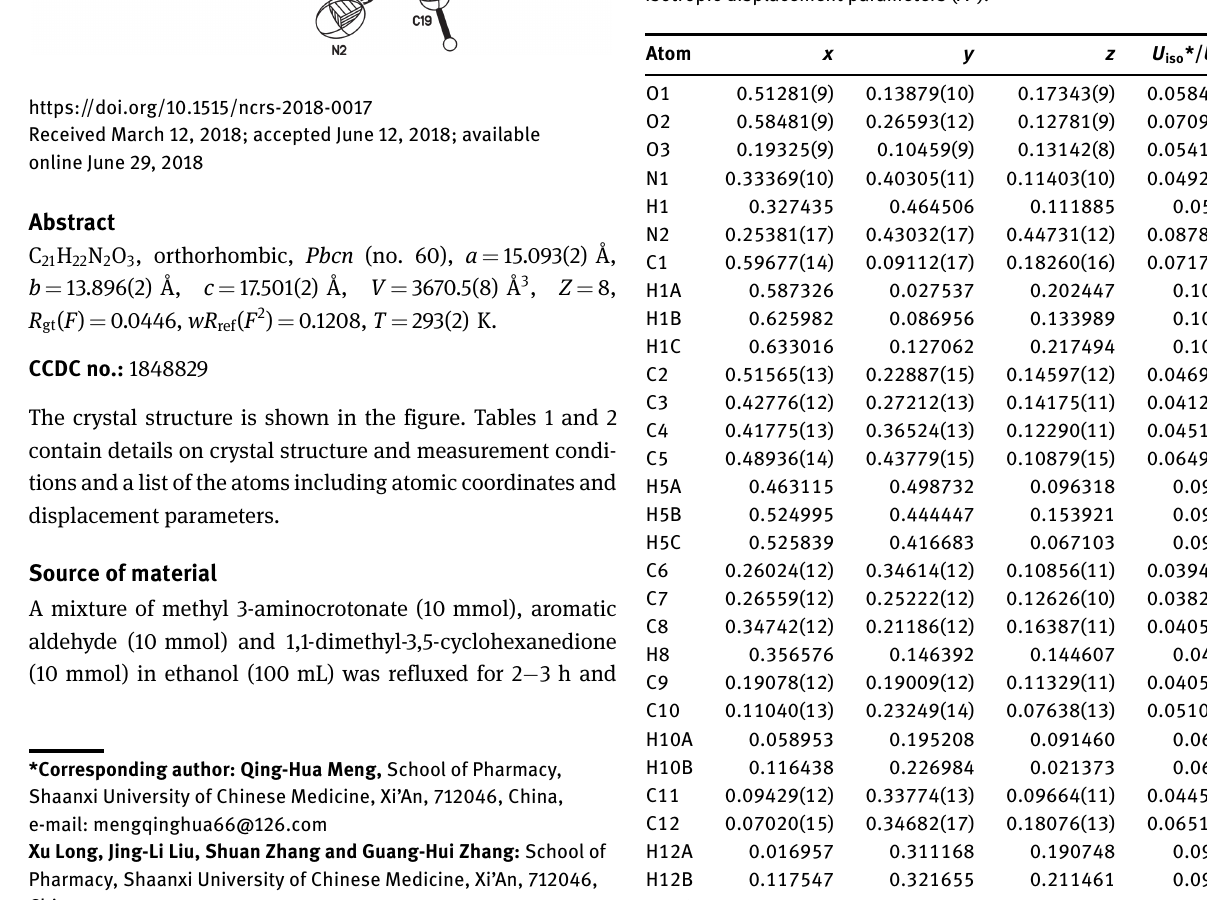
Table 2: Fractional atomic coordinates and isotropic or equivalent isotropic displacement parameters (Å 2